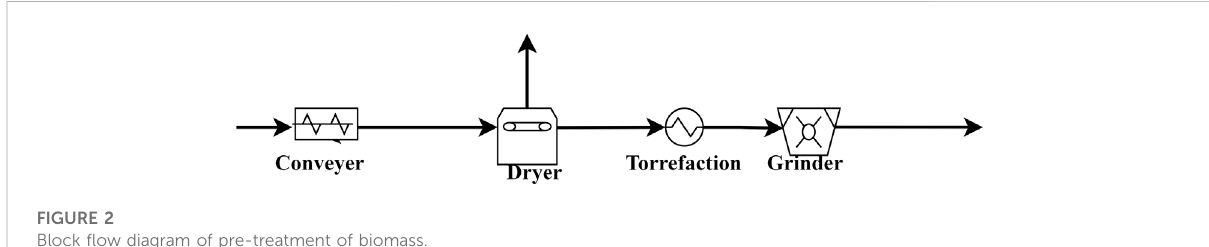
FIGURE 2 Block fl ow diagram of pre-treatment of